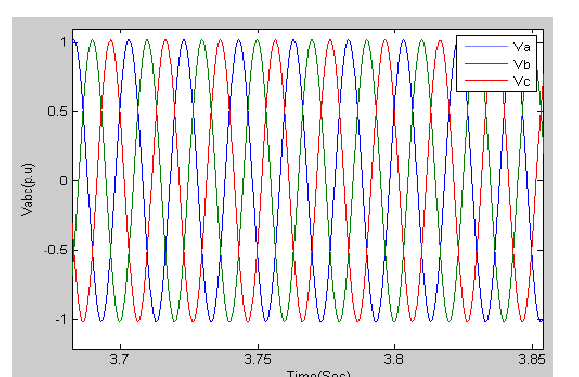
Fig. 9: Three Phase Voltages Vabc (P.U) of proposed SHP